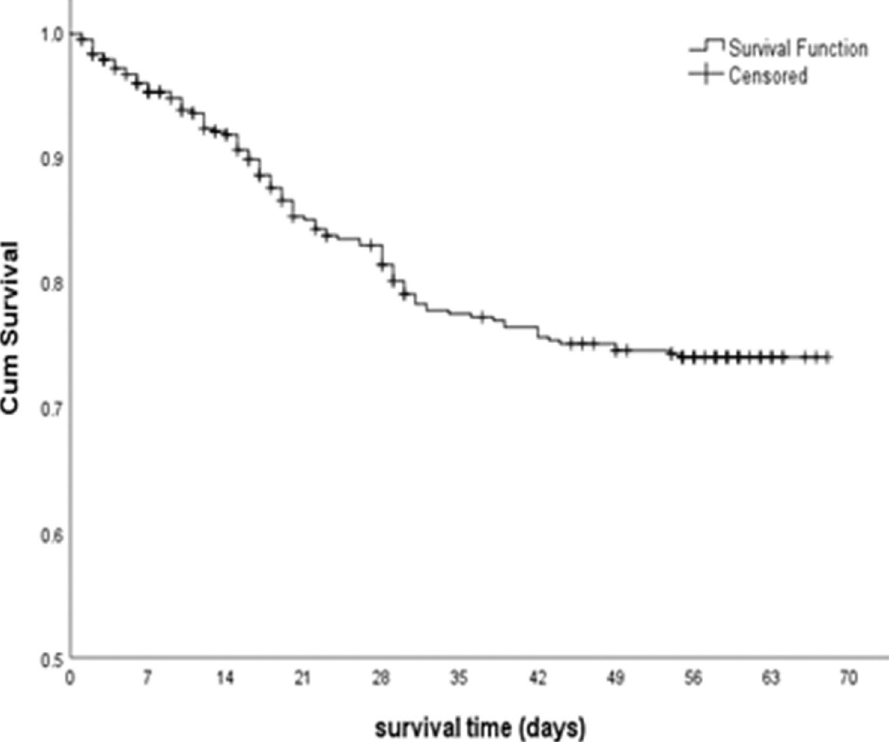
Figure 2. Survival distribution of early treatment interruption among new pulmonary TB smear-positive patients in urban districts, Selangor (n =